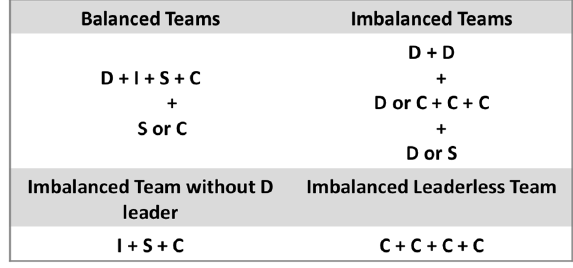
Figure 2. Team formation processes based on the DISC tool.